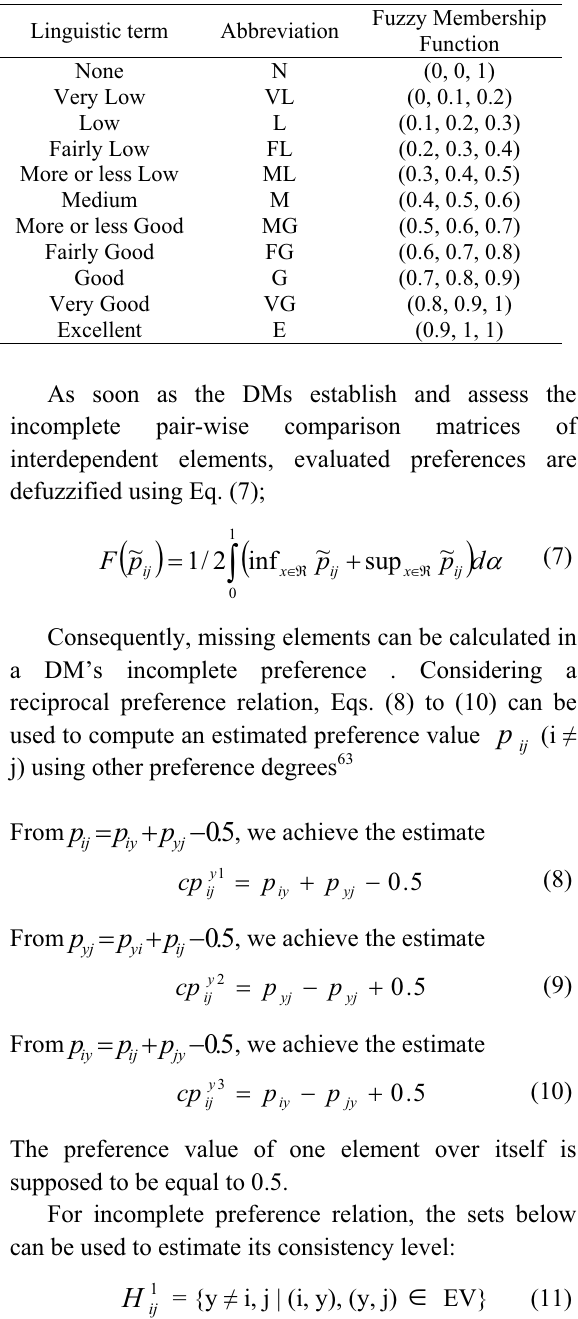
Table 1. Linguistic terms for